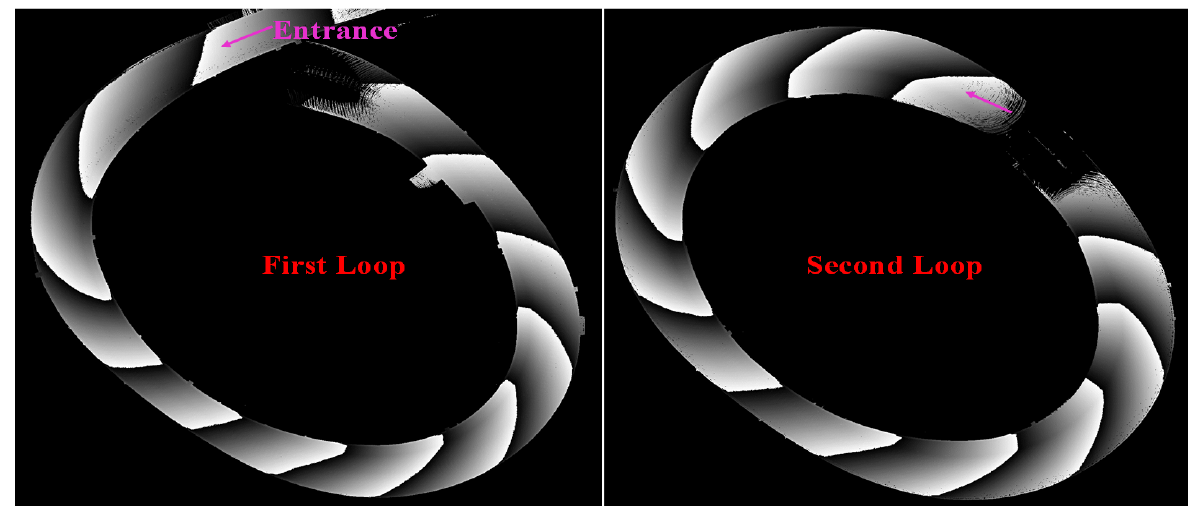
Figure 11. First and second loops in upward direction representing the top 200 cm of the road height. Bright-dark edges indicate increasing height by 2 m. Road slope is effectively and densely illustrated by grayness changes.